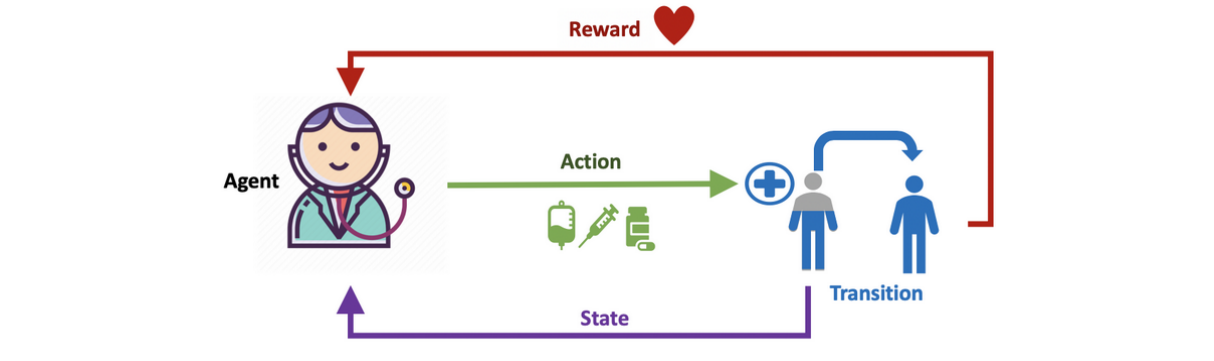
Figure 1. Illustration of reinforcement learning in critical